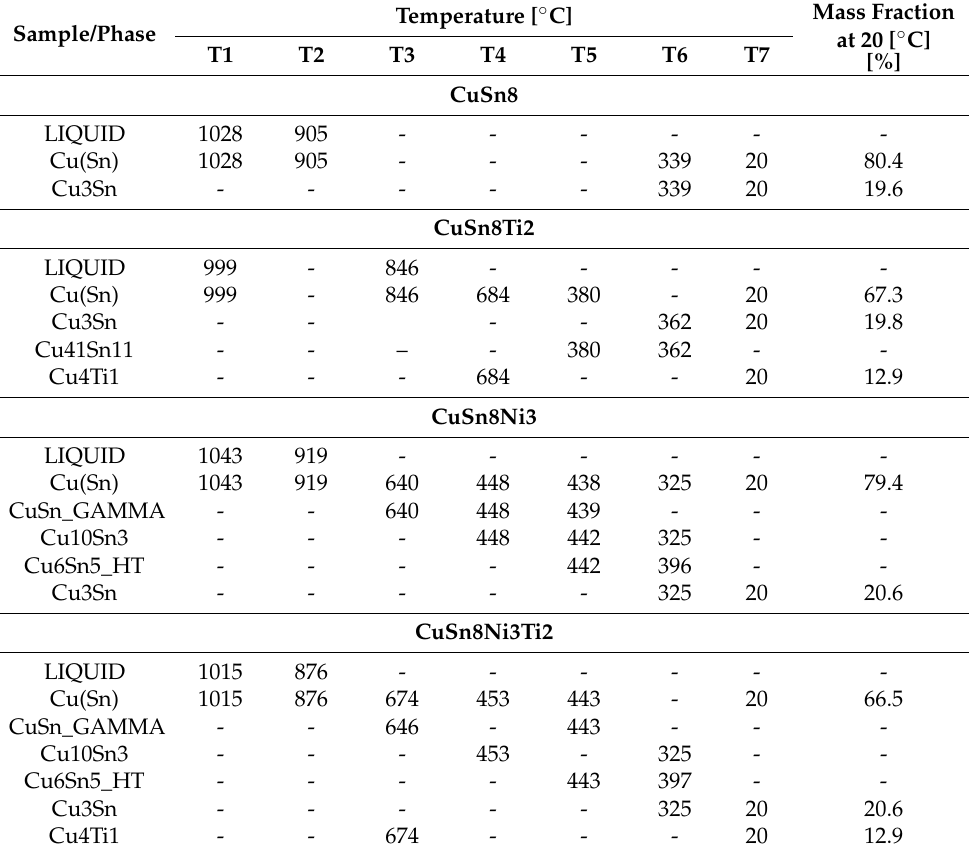
Table 3. Characteristic temperatures of crystallisation processes during cooling of selected alloys: CuSn8 and CuSn8Ti2, on the bases of thermodynamic modelling by the CALPHAD method. Sample/Phase